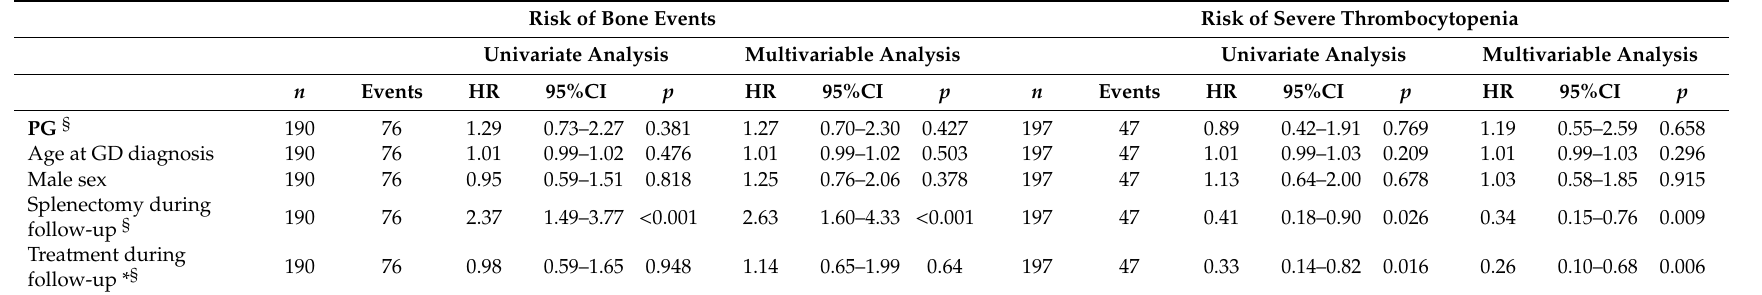
Table 3. Risk of bone events and severe thrombocytopenia with PG.